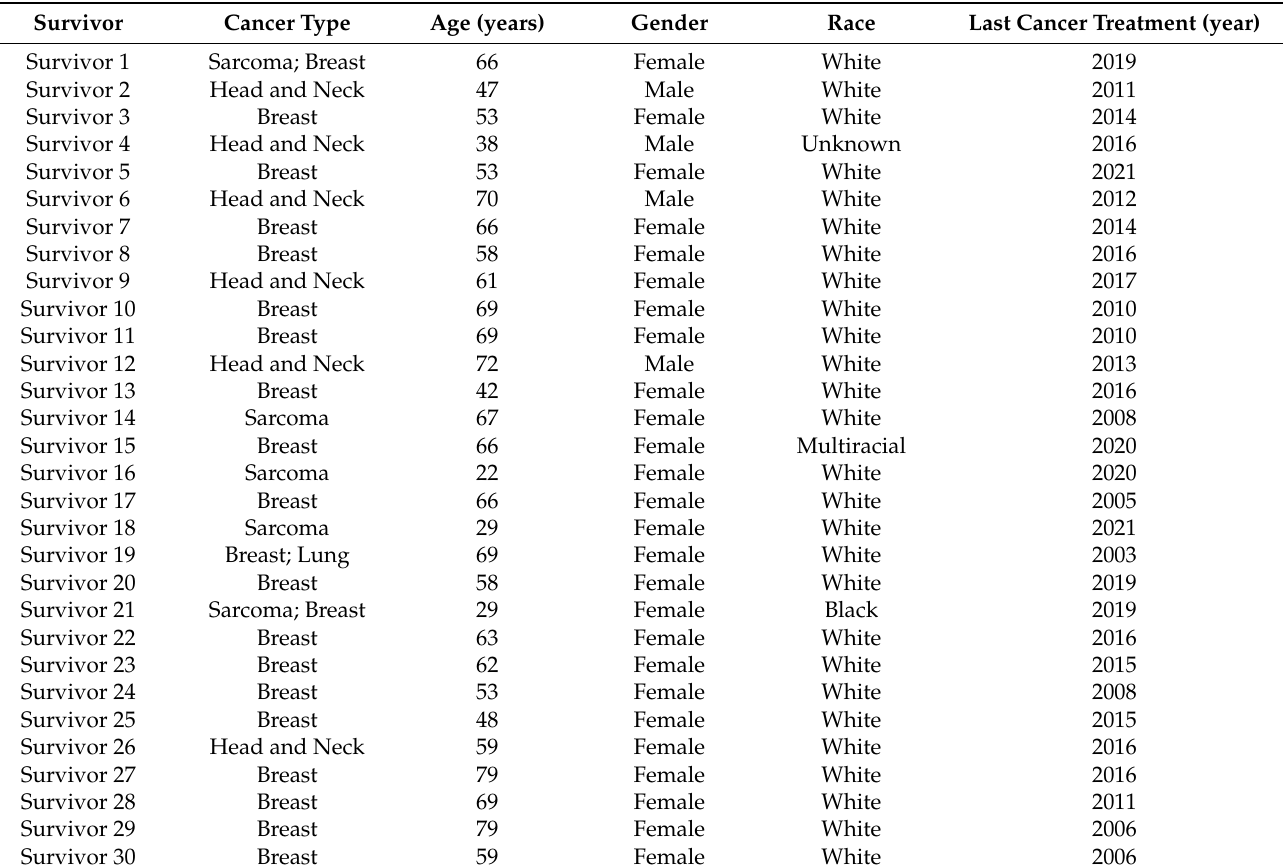
Table 1. List of Participants ( n =